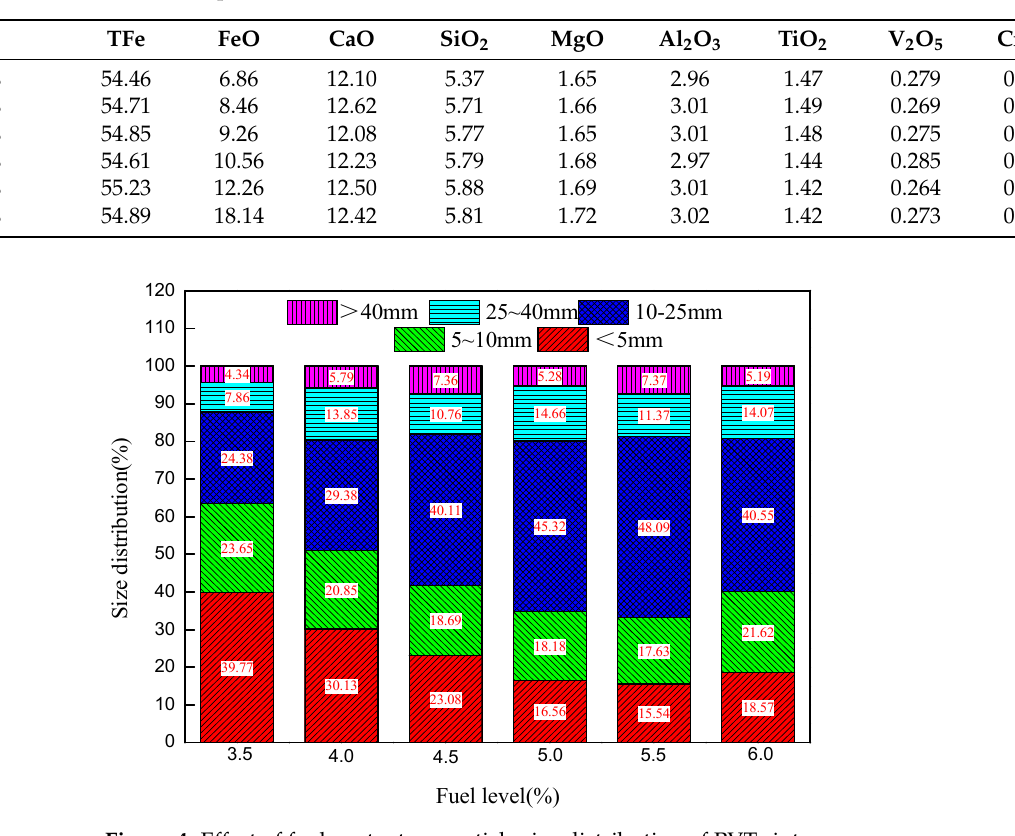
Figure 4. Effect of fuel content on particle size distribution of RVT sinter.